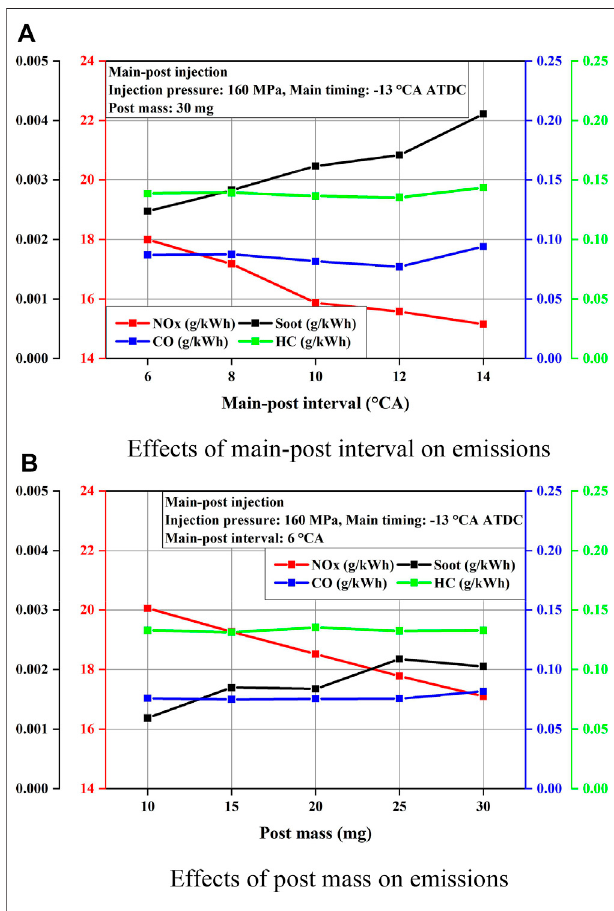
FIGURE9| Effectsofmain-postintervalandpostmassondistributionof fuel energy. (A) Effects of main-post interval on distribution of fuel energy, (B) Effects of post mass on distribution of fuel energy.